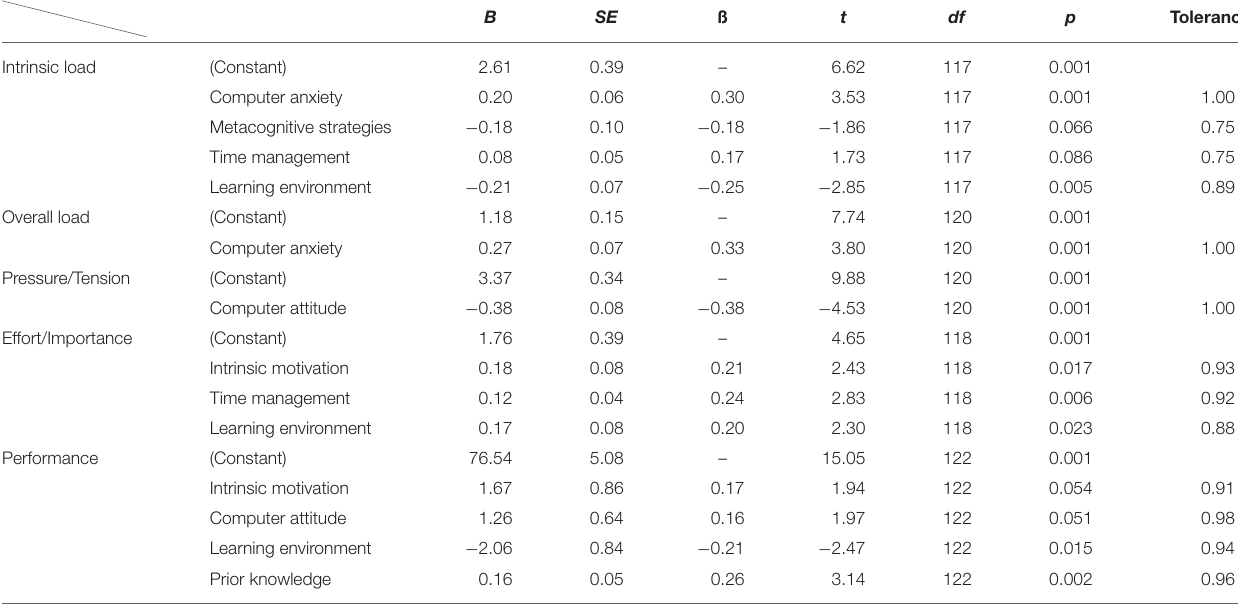
TABLE 4 | Results of the multiple linear regression analyses using the backward elimination